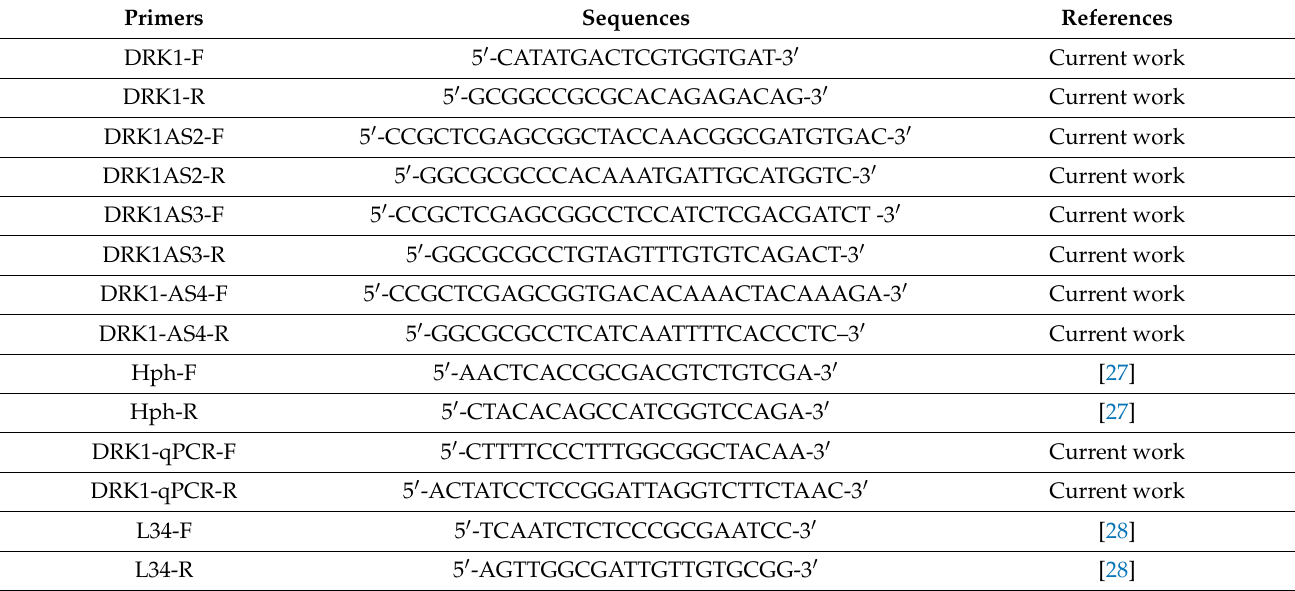
Table 1. Oligonucleotides used in this